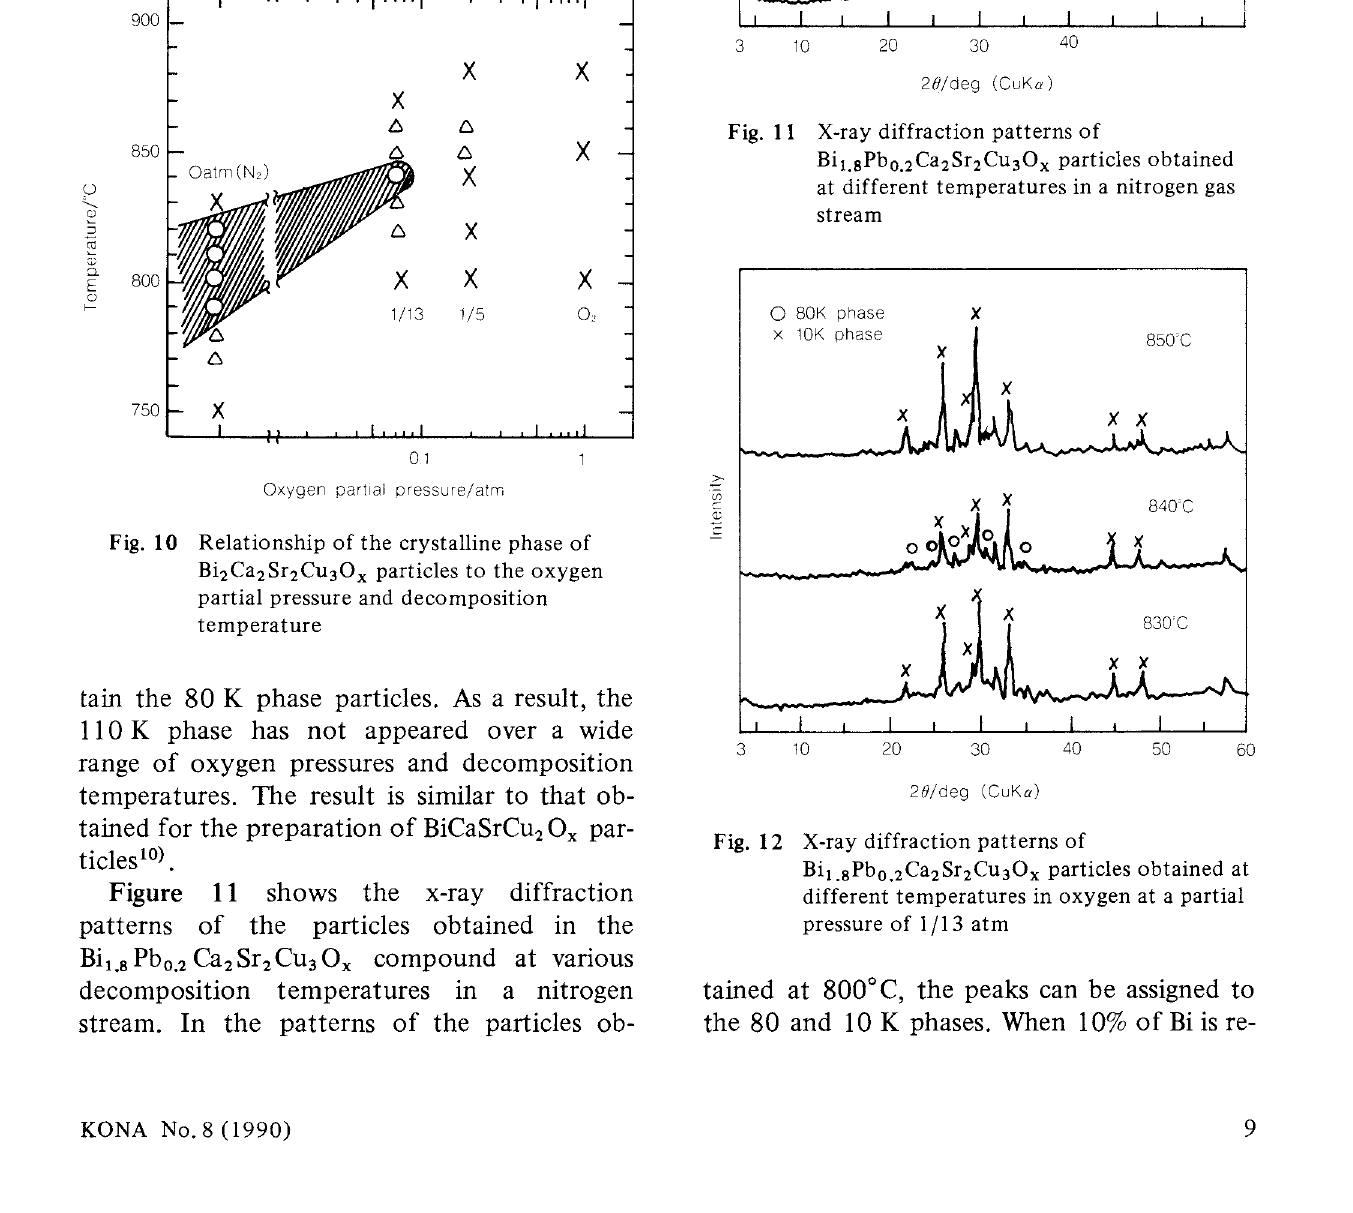
Fig. 12 X-ray diffraction patterns of Bi1.sPb .2Ca2Sr2Cu30x particles obtained at 0 different temperatures in oxygen at a partial pressure of 1/13